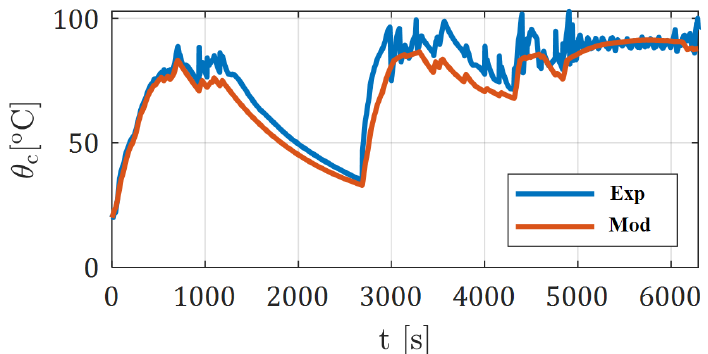
Figure 5. Evolution of the coolant temperature in a RDE with the ICE. Comparison between experi- mental results and control-oriented